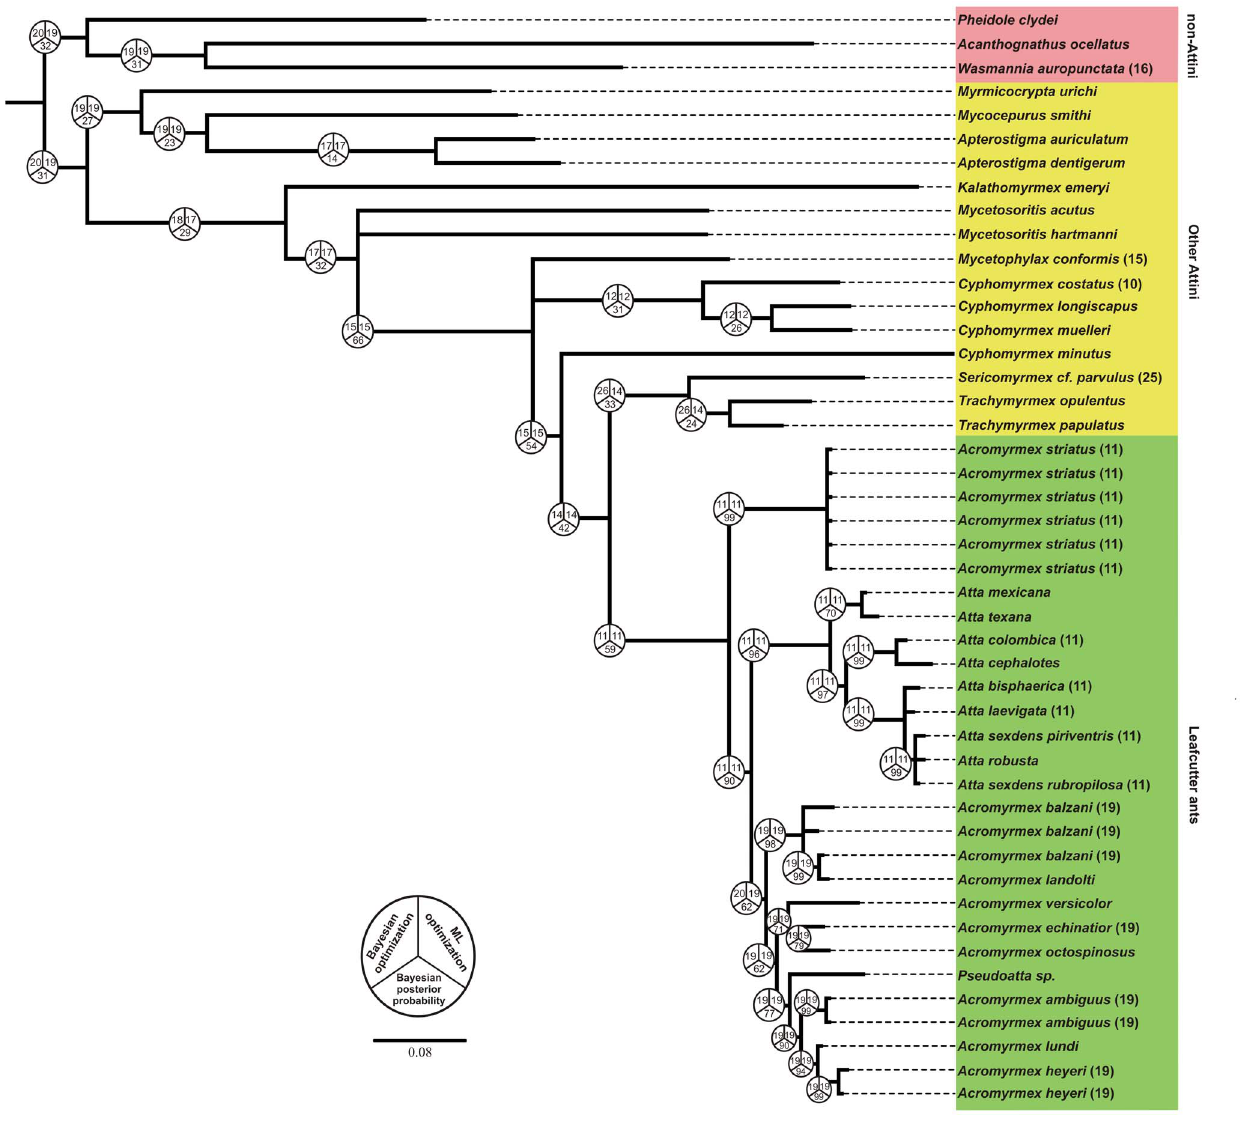
Figure 5. Ancestral haploid chromosome state reconstruction inferred under Bayesian and Maximum Likelihood optimizations, with out-groups (other Attini and non-Attini) included and known chromosome states (tips). Pie charts at nodes represent the inferred chromosome number in both approaches and its Bayesian posterior probabilities.